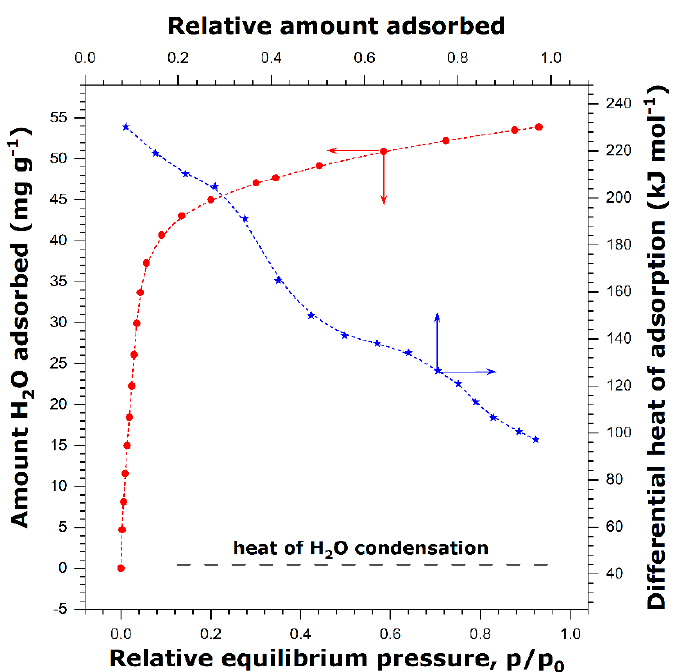
Figure 2. Adsorption isotherms (red circles) and differential heat of adsorption (blue stars) curves for Ce-13X on which the adsorption of water vapor was carried out at 298 K after the degassing treatment at 353 K. The quantity of adsorption is plotted against the relative equilibrium pressure, p/p 0 , where p 0 is the saturated vapor pressure. The differential molar heat of adsorption (blue stars) is represented as a function of the relative amount adsorbed, calculated as a ratio between a given quantity of adsorption and its value at p/p 0 = 0.8. The dashed lines are a guide for the eye.